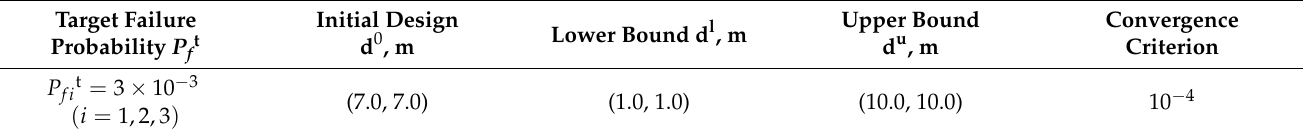
Table 5. Target failure probability and parameters for design variables and optimization.